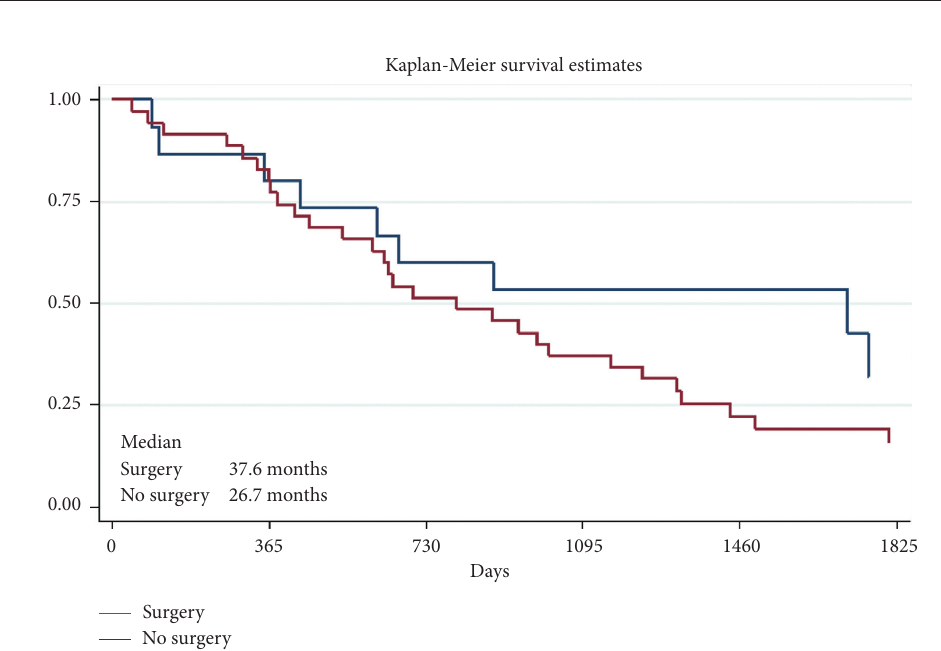
Figure 2: Survival results of the patients treated by surgery ( p � 0 .